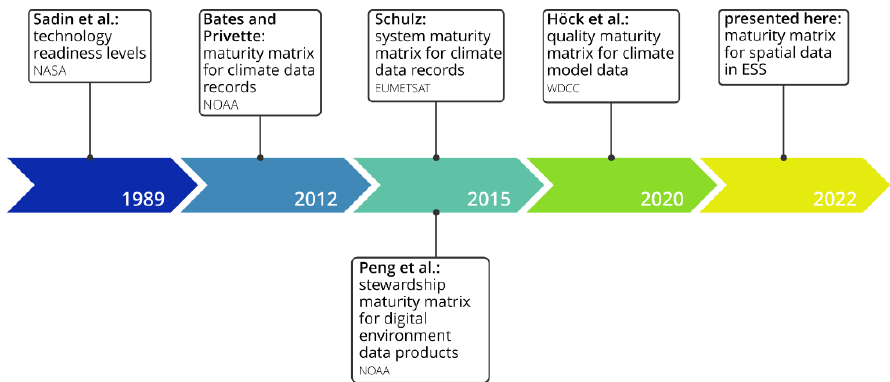
Figure 3. Timeline of maturity matrix development in refs. [28,30,32 – 34] including our developed Figure concept.